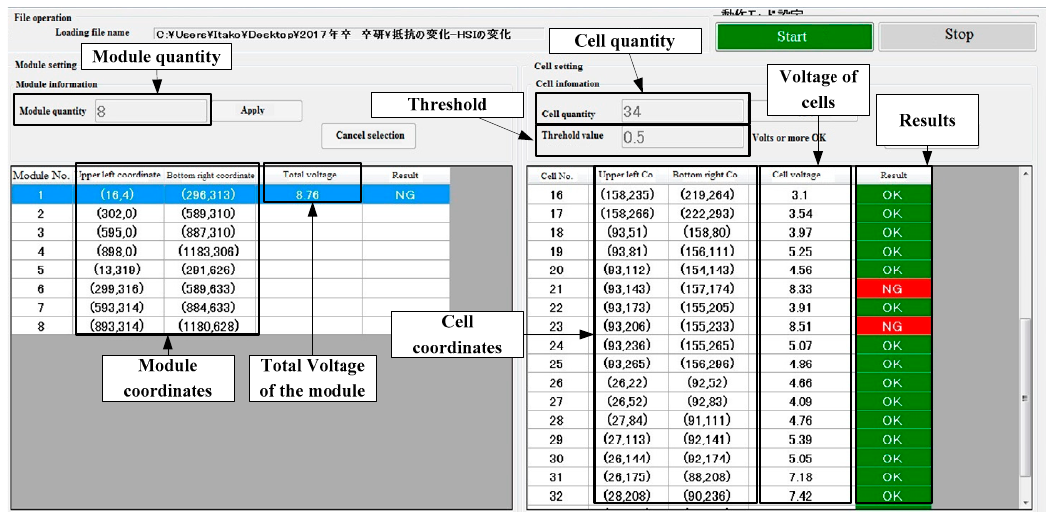
Figure 13. Detection monitor interface, all parameters and data of the detection are gathered here.